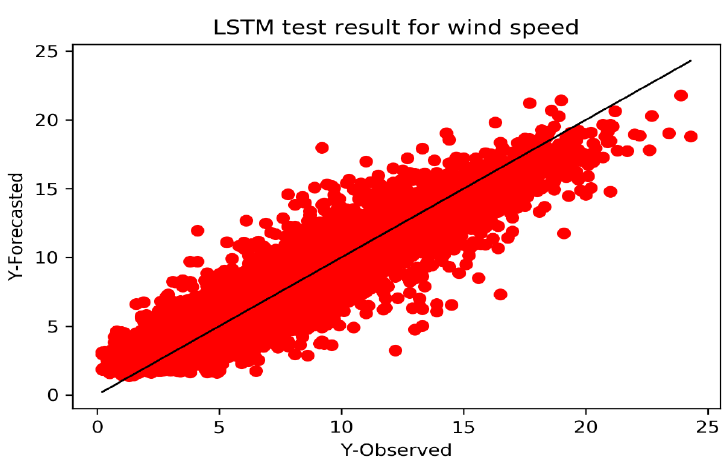
Figure 11. LSTM-based wind speed model error analysis.